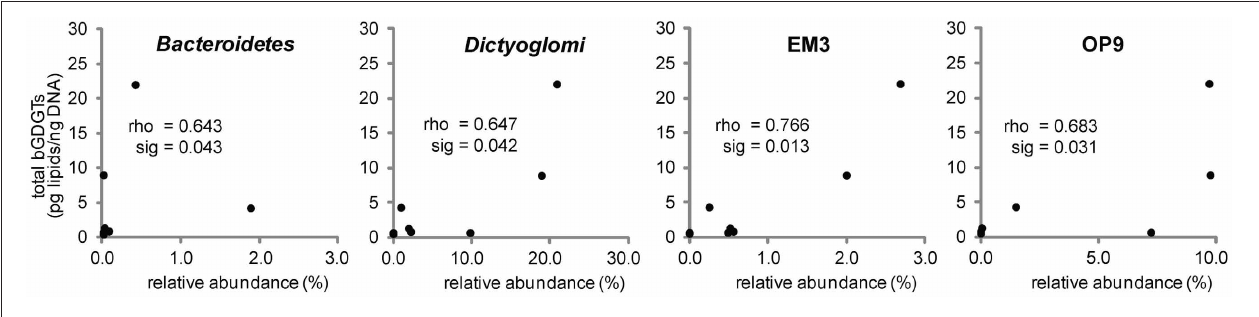
FIGURE 4 | Spearman’s rho correlation coefficients indicated statistically significant, positive relationships between bGDGT absolute abundance and the bacterial Bacteroidetes, Dictyoglomi,